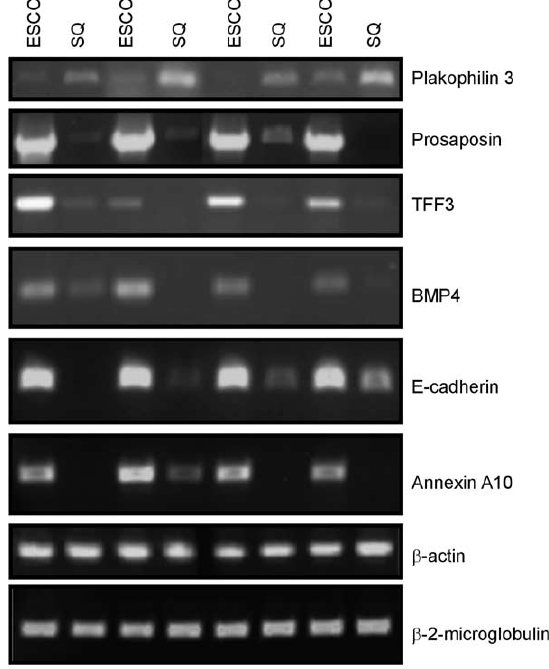
Fig. 4. RT-PCR to validate SAGE results of esophageal squamous cell carcinoma and normal squamous epithelium. RT-PCR on RNA from esophageal squamous cell carcinoma (ESCC) and normal squa- mous esophagus (SQ) biopsies from different patients, demonstrates that Prosaposin, Trefoil Factor (TFF) 3, Bone Morphogenetic Pro- tein (BMP) 4, E-Cadherin and Annexin A10 are highly expressed in esophageal squamous cell carcinoma, whereas Plakophilin 3 is highly expressed in normal squamous esophagus biopsies. β -actin and β -2-microglobulin were used as a control. Pictures are represen- tative for results of 13 patients.